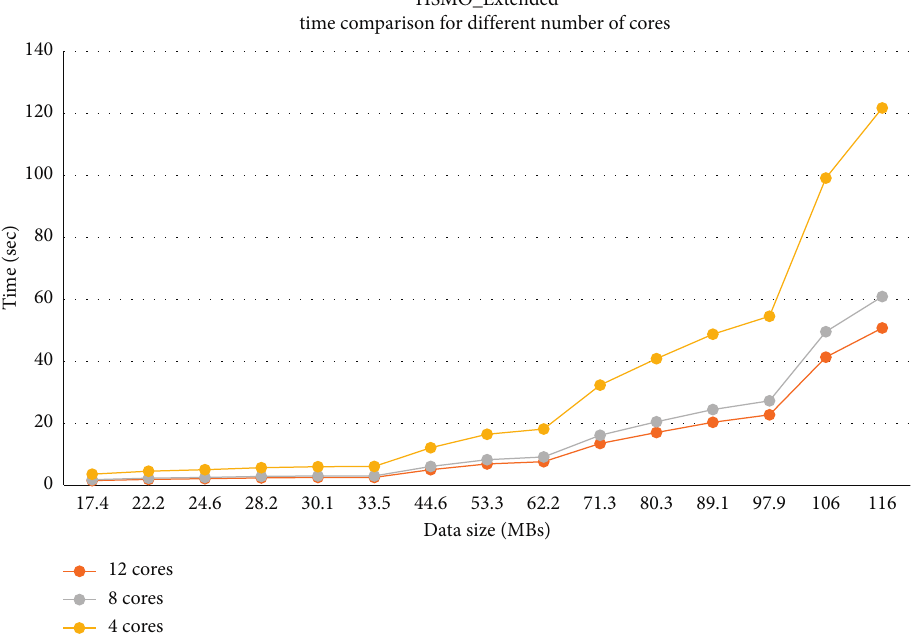
Figure 12: HSMO_Extended/time comparison for different number of cores.